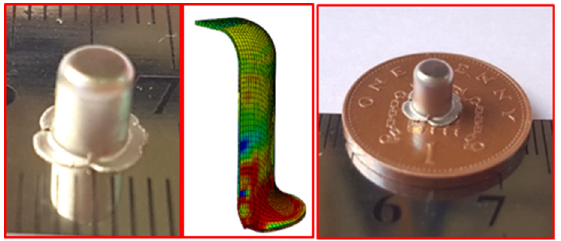
Fig. 18. Comparison between physical and simulated cups that have aspect ratio